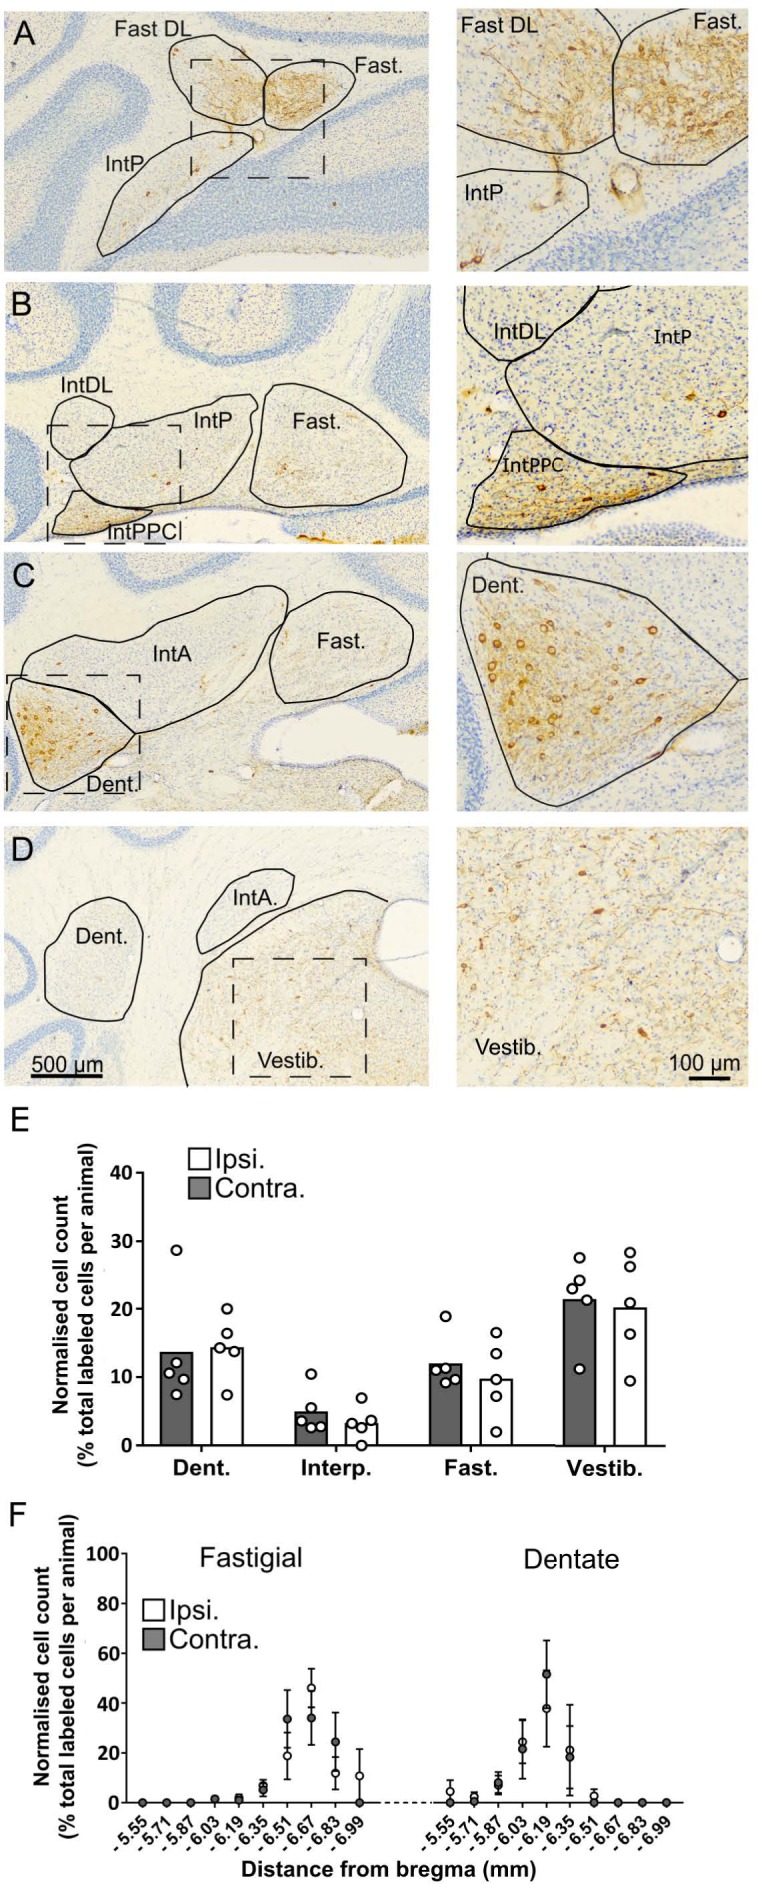
The topographical distribution of DCN labeling at 66 hr.(A-D) representative photomicrographs showing labeling in the ipsilateral cerebellar and vestibular nuclei 66 hr after hippocampal rabies injection. Left panels show low magnification view, right panels show high-magnification view of area indicated by dashed box. E, Pooled, normalized counts of rabies labeled cells in the ipsi- and contralateral cerebellar and vestibular nuclei (n = 5 mice). No significant differences were found between ipsi- and contralateral nuclei (nuclei x hemisphere two-way ANOVA, hemisphere effect F (1, 4)=1.14, p=0.35, interaction effect F (3, 12)=0.21, p=0.89, nuclei effect F (3, 12)=7.88, p=0.004). F, Normalized cell counts in the fastigial nucleus (left) and dentate nucleus (right) according to their rostro-caudal position relative to Bregma. Open circles, contralateral count; filled circles, ipsilateral count (n = 5 mice). Abbreviations: Dent., Dentate nucleus; Fast., fastigial nucleus; Fast. DL, dorsolateral fastigial nucleus; Interp., nucleus interpositus; IntA, nucleus interpositus anterior; IntDL, dorsolateral nucleus interpositus; IntP, nucleus interpositus posterior; Vestib., vestibular nuclei.